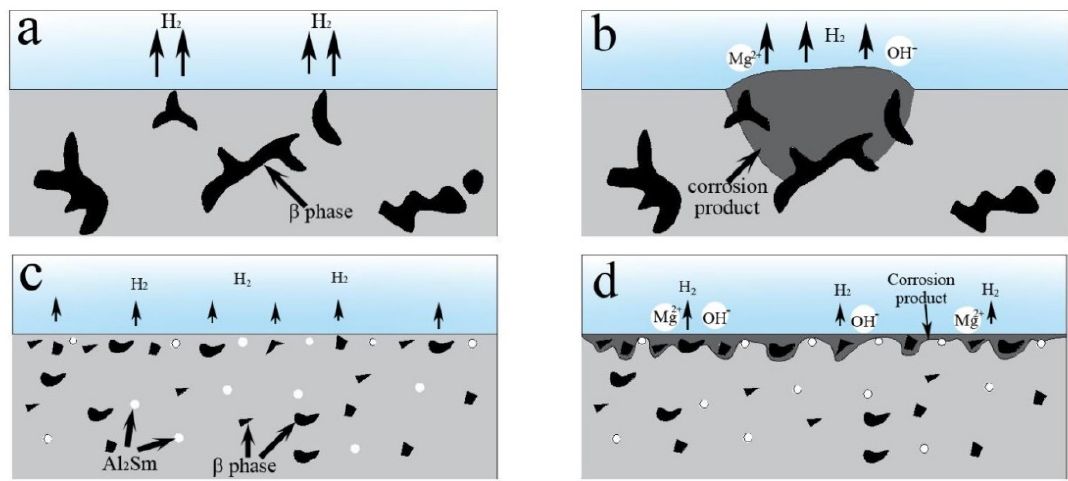
Figure 13. Schematic illustrations of the ultrasonic-treated ( a , b ) AZ91 alloy and ( c , d ) AZ91–1.5Sm alloy during the corrosion process.